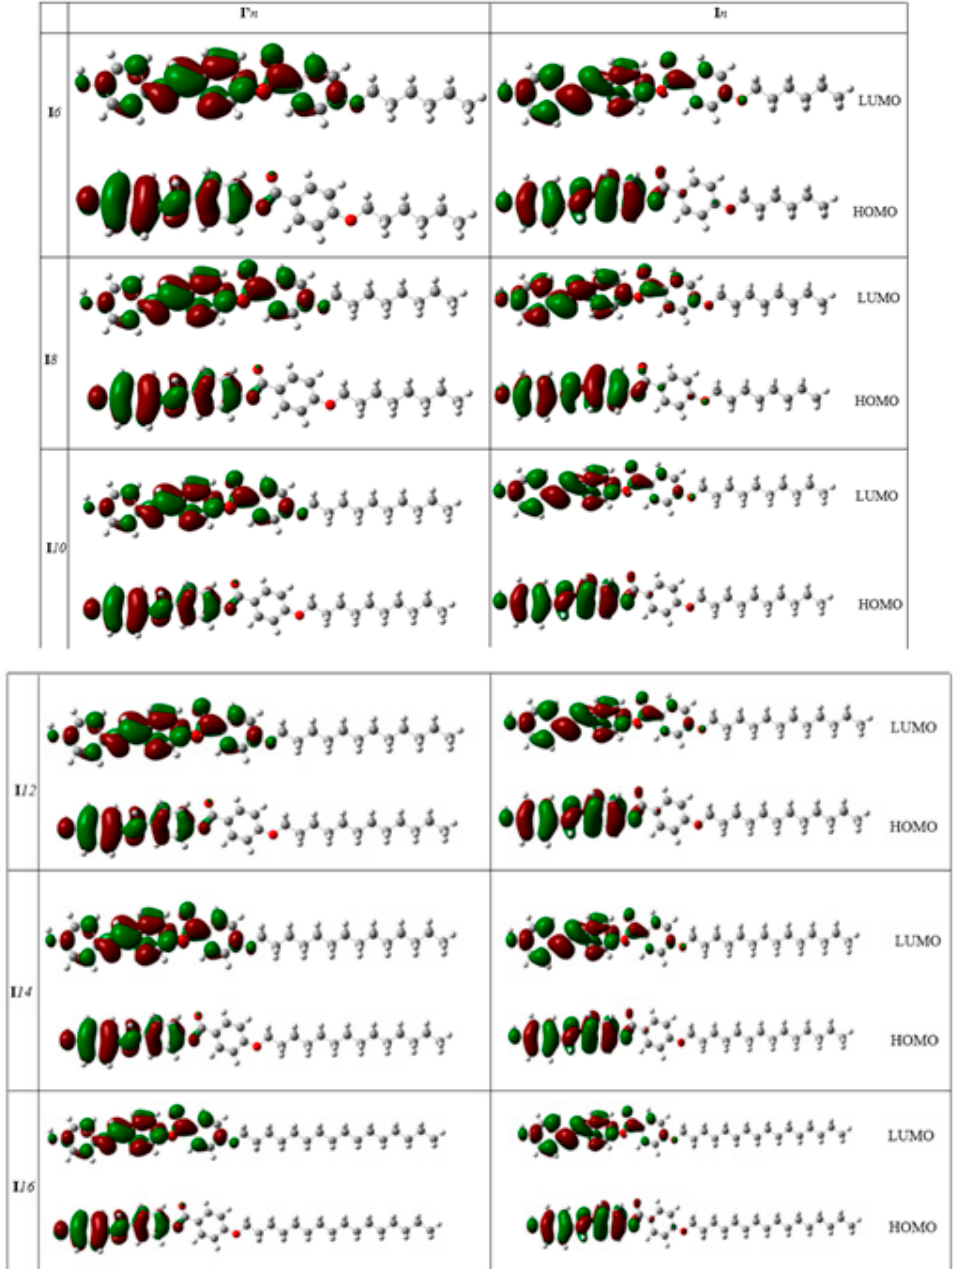
Figure 5. FOM’s calculated at B3LYP/6-31G(d.p) for investigated series I n .